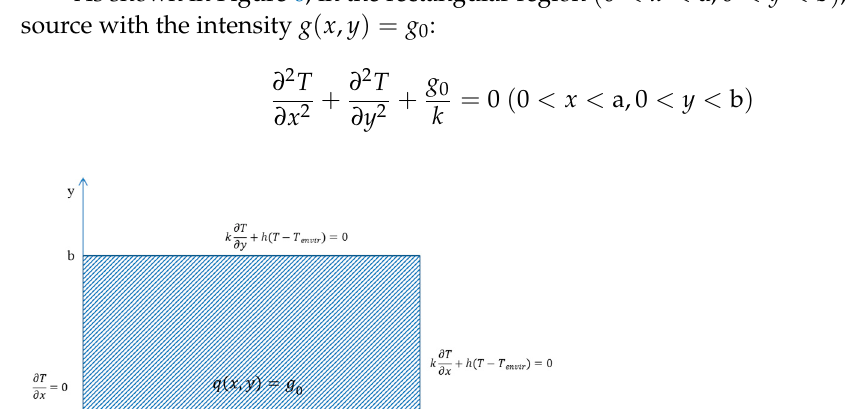
Figure 5. Neutronics calculation results of benchmark TWIGL (( a ) linear perturbation and ( b ) step perturbation).